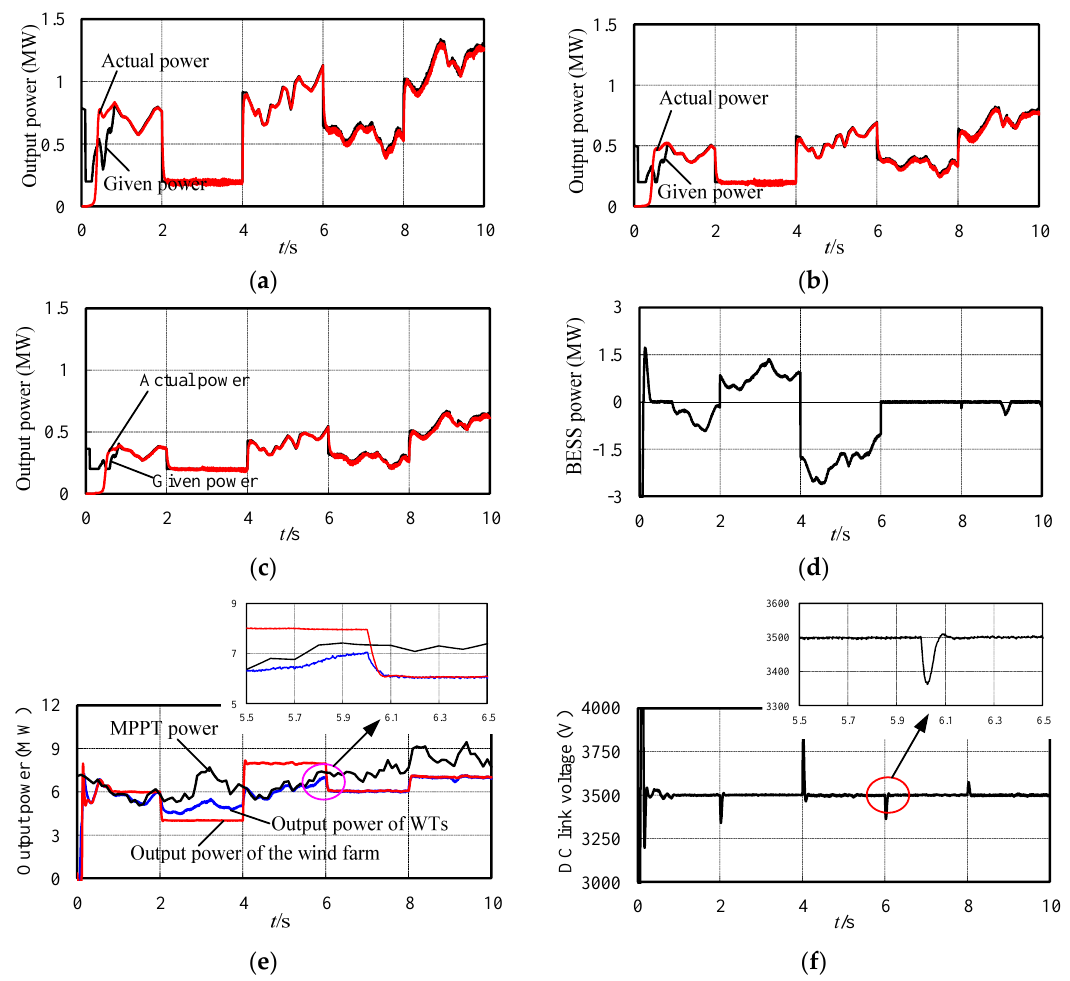
Figure 13. Time histories of the wind farm under the specified power given operation mode. ( a ) Output power of CWT (WT7). ( b ) Output power of CWT (WT8). ( c ) Output power of CWT (WT9). ( d ) Total output power of the wind farm. ( e ) Power of the BESS; ( f ) DC link voltage.